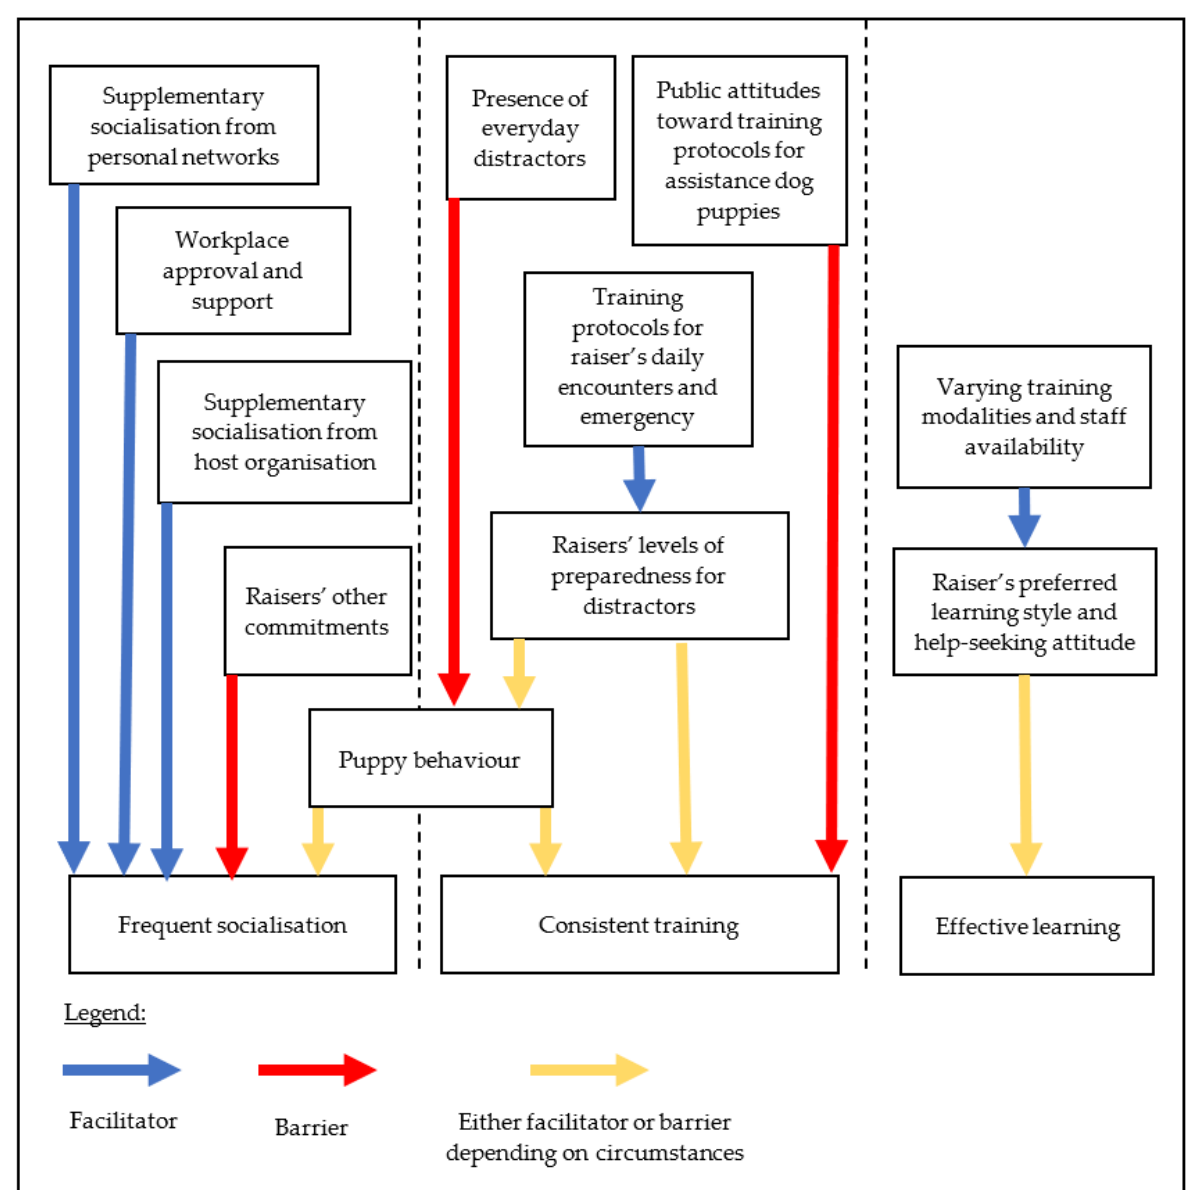
Figure 1. Multiple levels of facilitators and barriers to raiser’s engagement in recommended prac- tices.